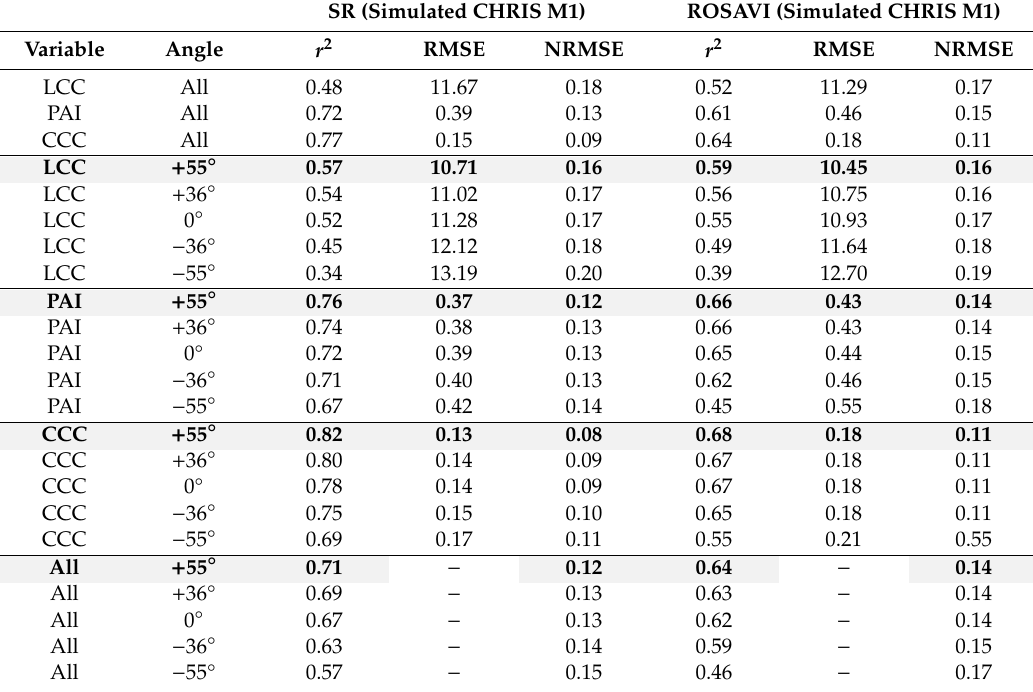
Table 9. SR and ROSAVI model performance for plot scale data averaged over all sites and VZAs using the LHS PROSAIL simulated CHRIS M1 dataset. RMSE cv units: LCC ( µ g / cm 2 ); PAI (unitless); CCC (g / m 2 ). NRMSE cv = RMSE cv / range of measured data. The top angle-based results are highlighted and